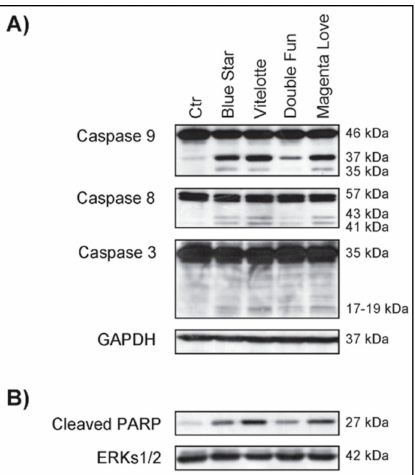
Figure 1. Polyphenol and anthocyanin-rich extracts (PAE) from S. tuberosum varieties restored the apoptotic program in U937 cancer cells, as compared to untreated U937 control cells (Ctr). ( A ) Western blot analysis of the indicated proteins in U937 cells after PAE treatment from “Magenta Love”, “Blue Star”, “Double Fun”, and “Vitelotte” varieties at 2.5 mg / mL for 24 h. Glyceraldehyde 3-phosphate dehydrogenase (GAPDH) detection was used as loading control. ( B ) Western blot analysis of the indicated protein in U937 cells after PAE treatment at 2.5 mg / mL for 24 h. Extracellular signal-regulated protein kinases 1 and 2 (ERKs 1 / 2) were used as loading